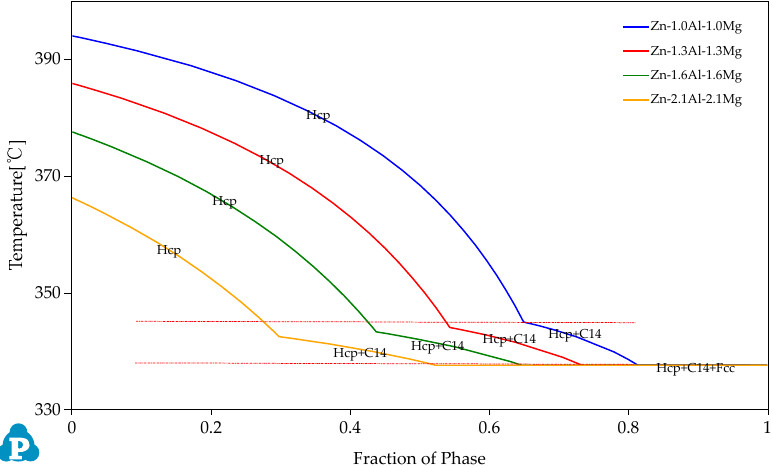
Figure 7. Non-equilibrium solidification (Scheil) curve of experimental coatings.